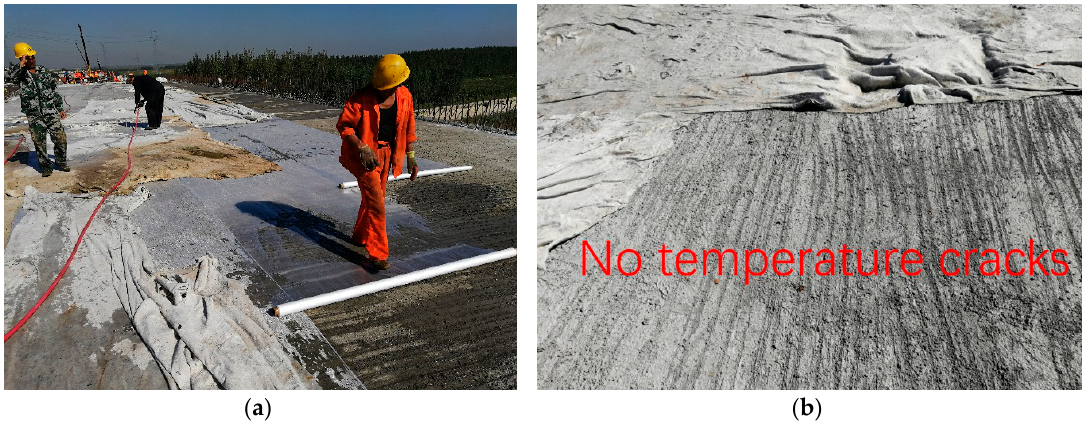
Figure 8. Photos of bridge deck: ( a ) curing; ( b ) 21 days after pouring.